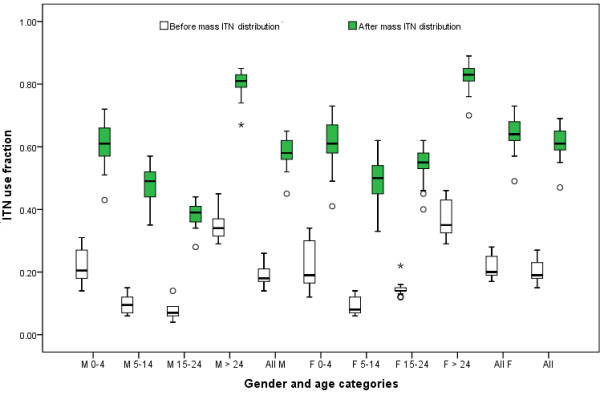
Distribution of insecticide-treated bed net use fraction according to gender and age categories (in year) before and after mass insecticide-treated bed net distribution. M and F refer to males and females, respectively.